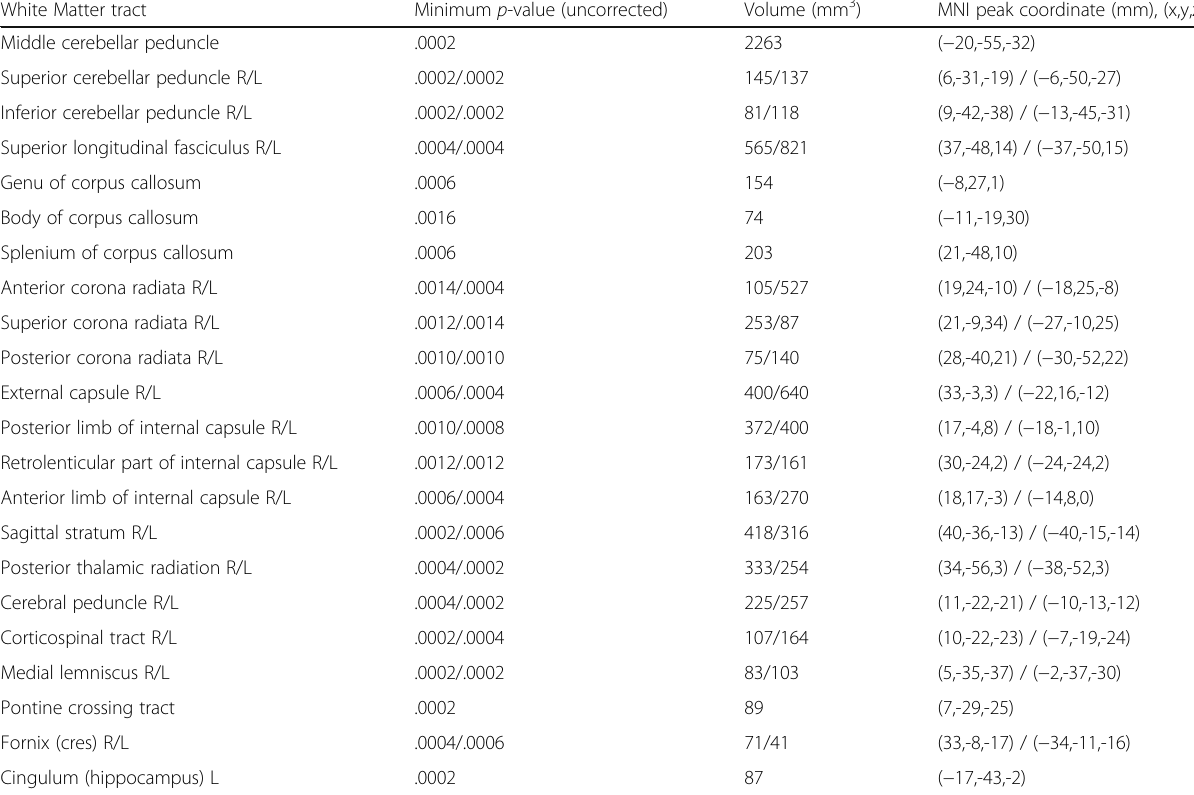
Table 2 White matter regions where significant decreased AD values were found in CM compared to